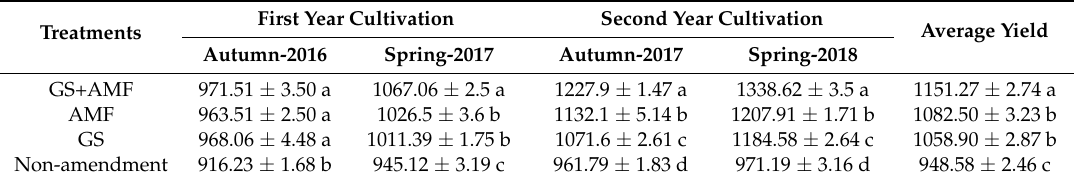
Table 4. The seasonal greenhouse cucumber yield (g/plant) in two years under plastic greenhouse vegetable cultivation (PGVC) amended and non-amended treatments.